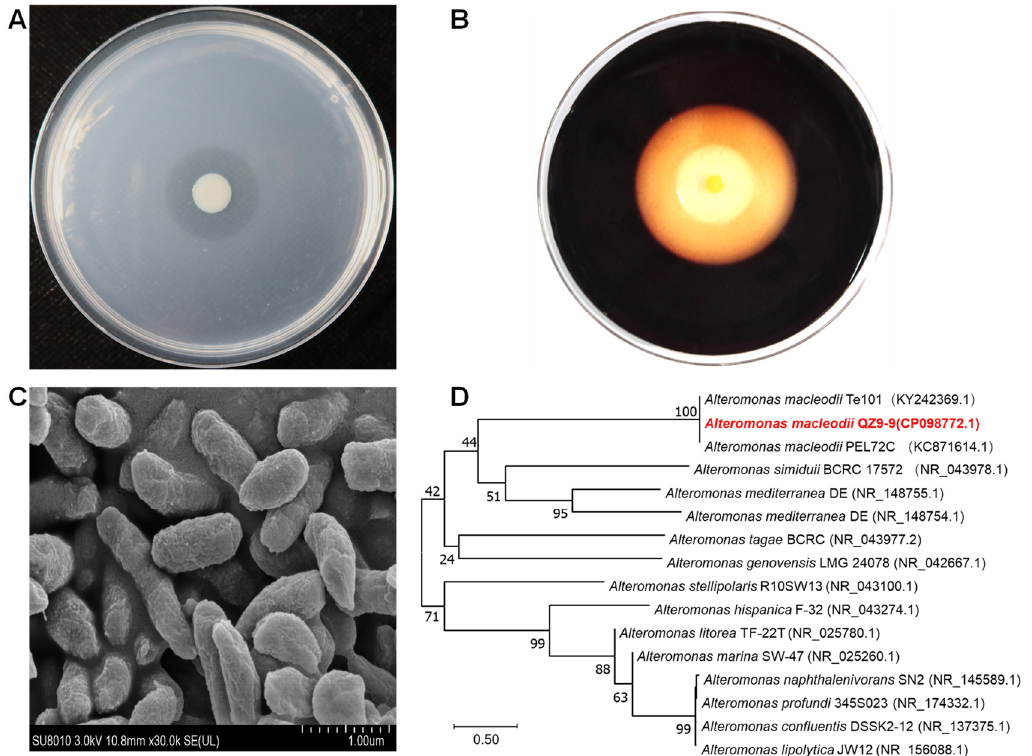
Figure 1. The morphology of agarolytic bacterial A. macleodii QZ9-9. ( A ) The colony of strain QZ9-9 on mineral salts agar plate after static incubation for 48 h, and a clear transparent hydrolysis zone surrounds this colony. ( B ) Hydrolysis zone colored with Lugol’s iodine solution after static incubation for 96 h on mineral salts agar plate. ( C ) Close-up of the electron microscopy of strain QZ9-9. ( D ) Phylogenetic tree of A. macleodii QZ9-9 (marked by red color) prepared using Mega 11.0 software. Note: the code in each parenthesis represents the sequence accession number in GenBank, and the number at each branch point is the percentage supported by